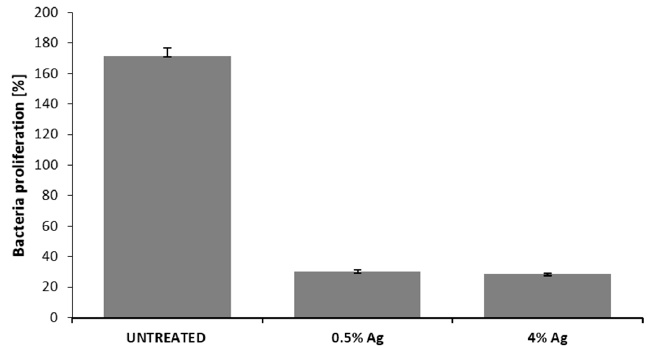
Figure 3. Bacterial proliferation expressed as percentage induced by the silver treated samples in comparison with the plain cotton gauze.